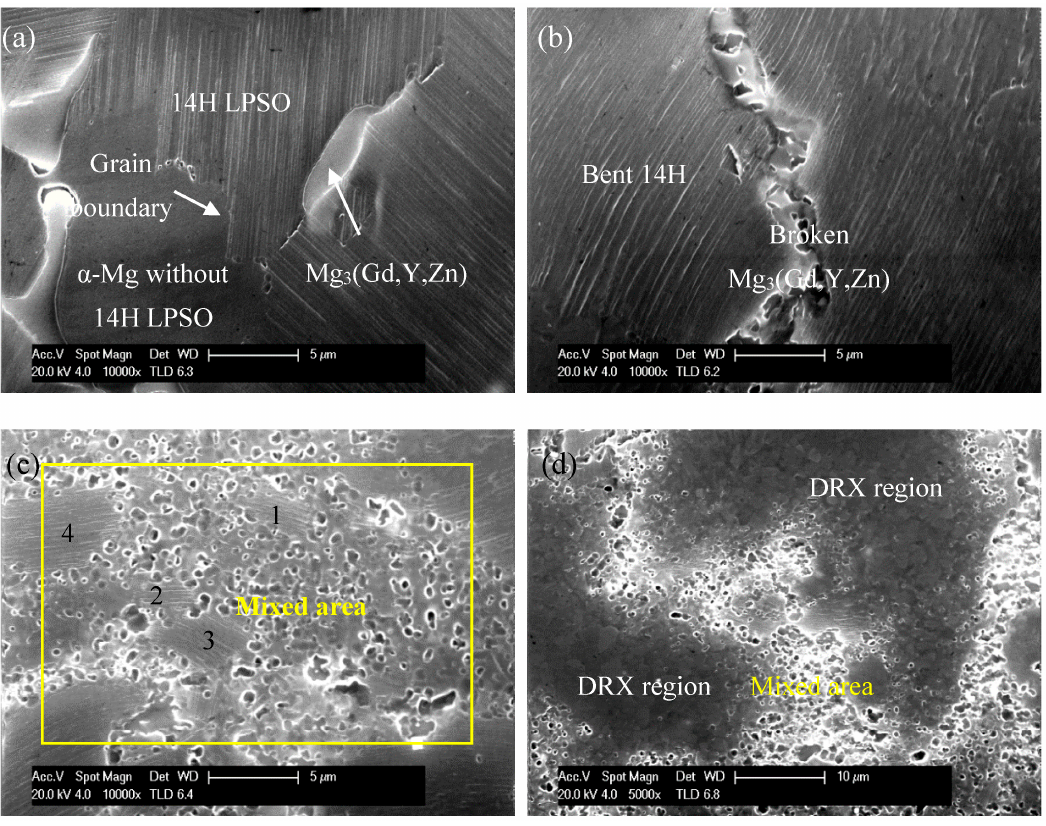
Figure 7. Typical SEM images showing the evolutions of various phases: ( a ) Cast alloy; ( b ) 1p ECAP; ( c ) 4p ECAP; ( d ) 12p ECAP (DRX: dynamic recrystallization).